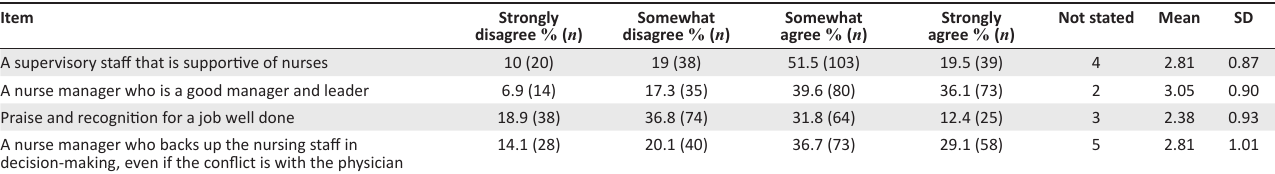
TABLE 2: Leadership ( n = 204).